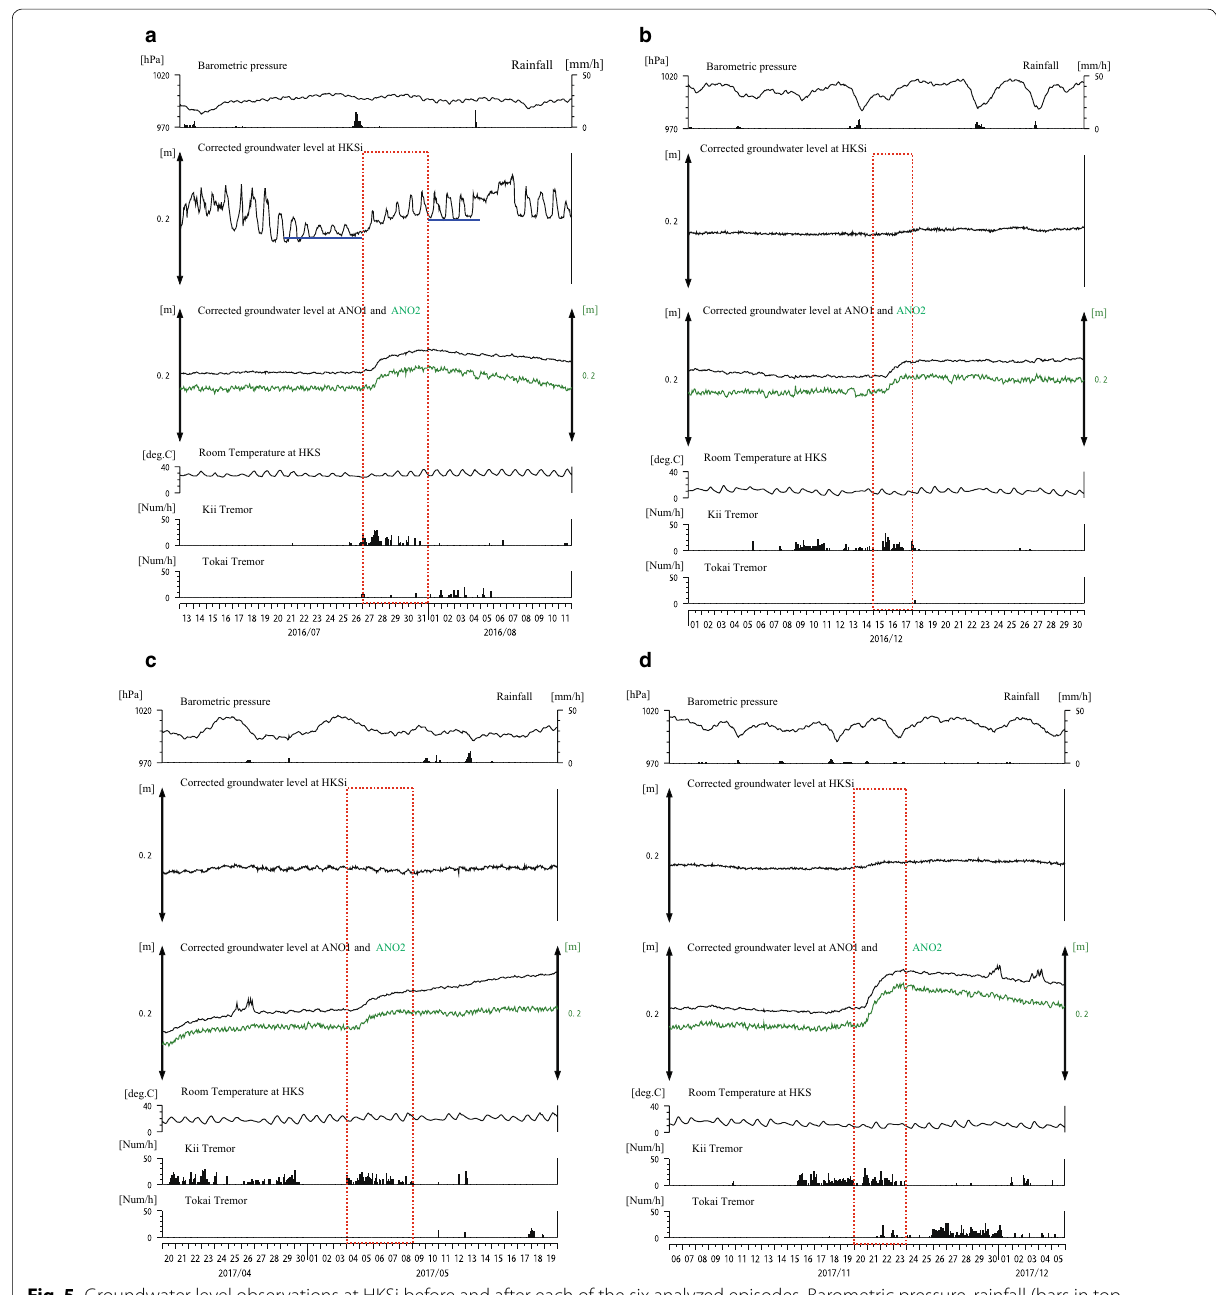
Fig. 5 Groundwater level observations at HKSi before and after each of the six analyzed episodes. Barometric pressure, rainfall (bars in top plots), corrected groundwater levels after the removing of the linear trends for 8 days just before the episodes at HKSi, ANO1, and ANO2, room temperature at HKS, and tremor occurrences in Kii and Tokai (see Fig. 1) are shown. However, in the case of f , removing of the linear trend from September 17 to 25 is used because data from September 26 to 28 noon are changed by short-term SSE around ANO. Barometric pressure and rainfall are refer to left and right scales, respectively. The six episodes occurred in a July 2016, b December 2016, c May 2017, d November 2017, e April 2018, and f September 2018. Red squares indicate the duration of the episodes. Because the groundwater level data in a were affected by room temperature fluctuations, the estimated groundwater level change during the episode is indicated by horizontal blue